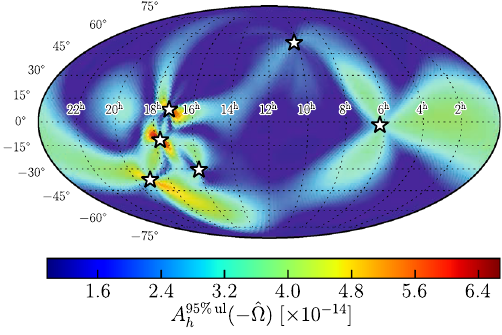
Fig. 86 95% confidence-level upper-limit map on the characteristic strain amplitude for an anisotropic background having spectral index α = − 2 / 3. The white stars show the location of the EPTA pulsars used for the analysis.